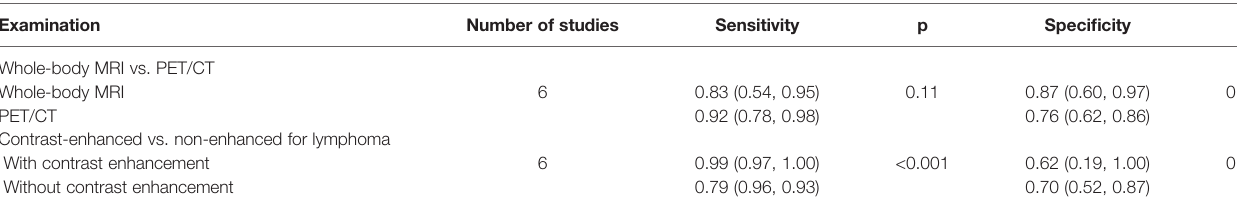
TABLE 3 | Comparison of speci fi c subgroups.